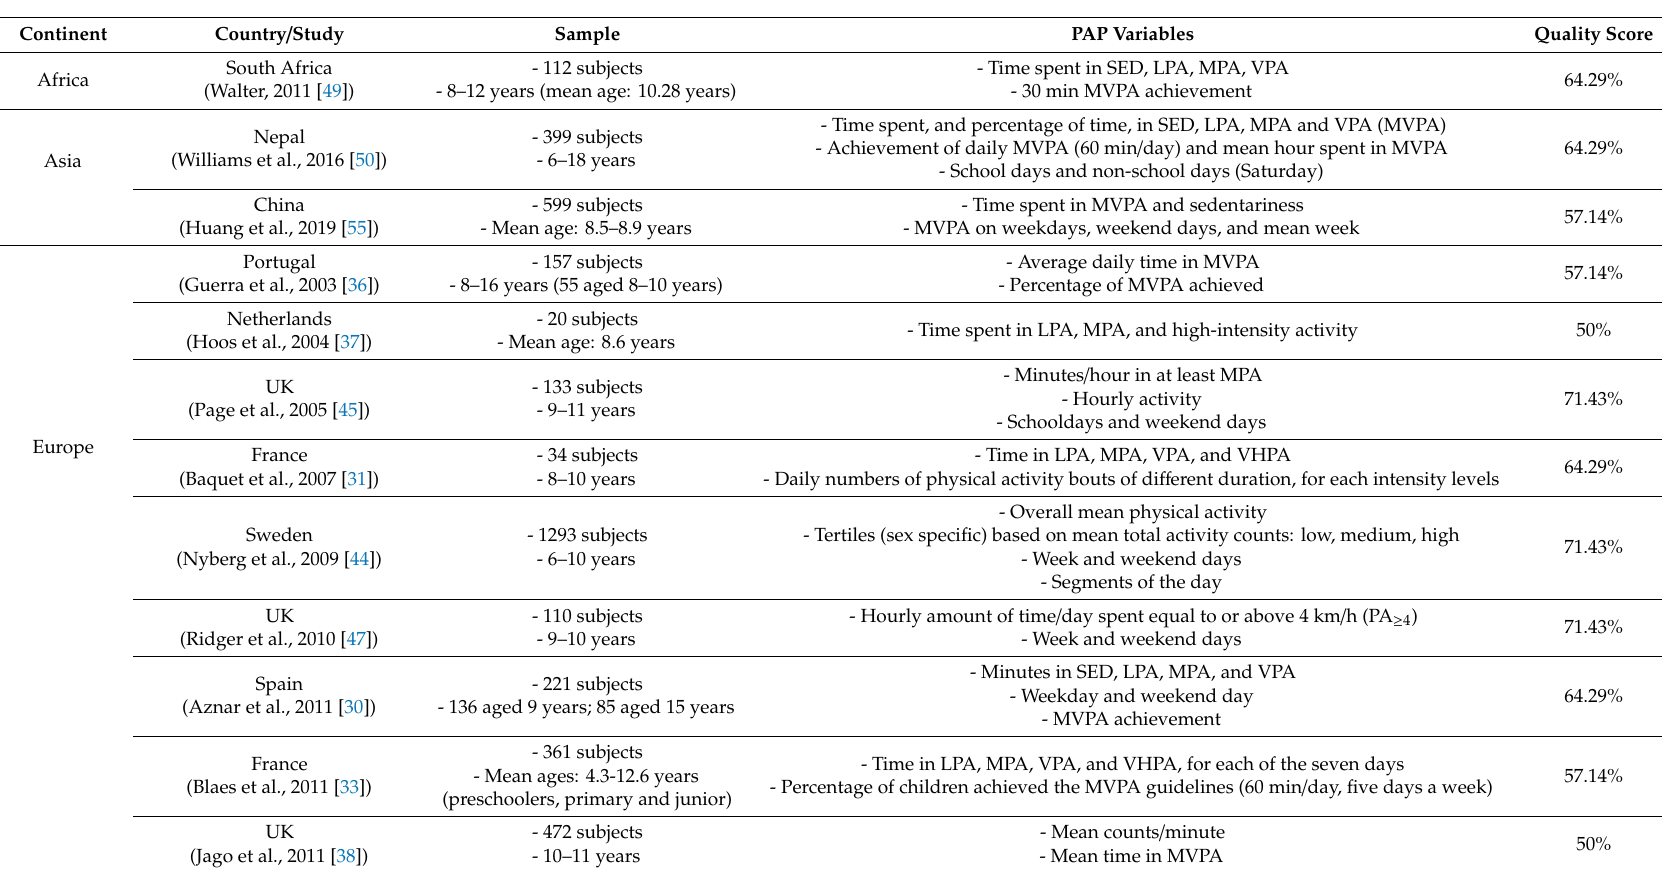
Table 2. Summary of the studies that used accelerometers to assess